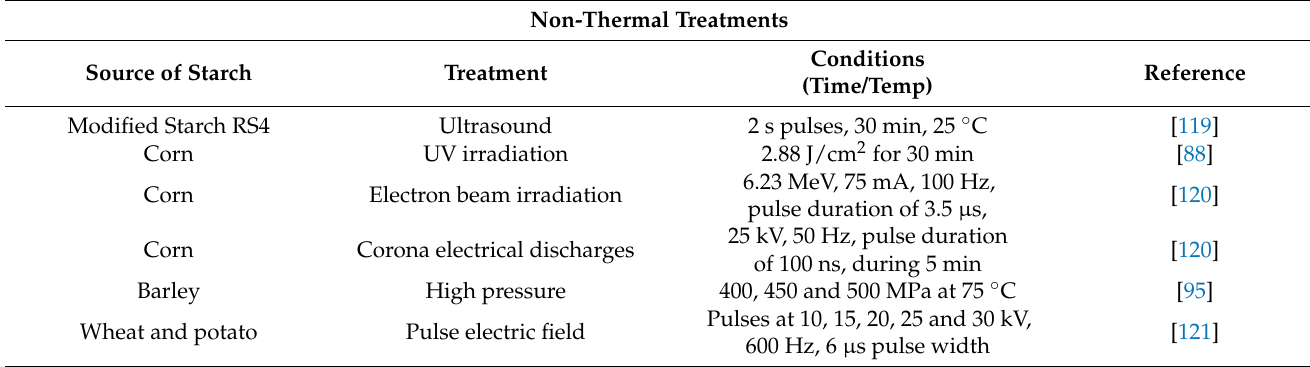
Table 3. Non-thermal treatments modification in